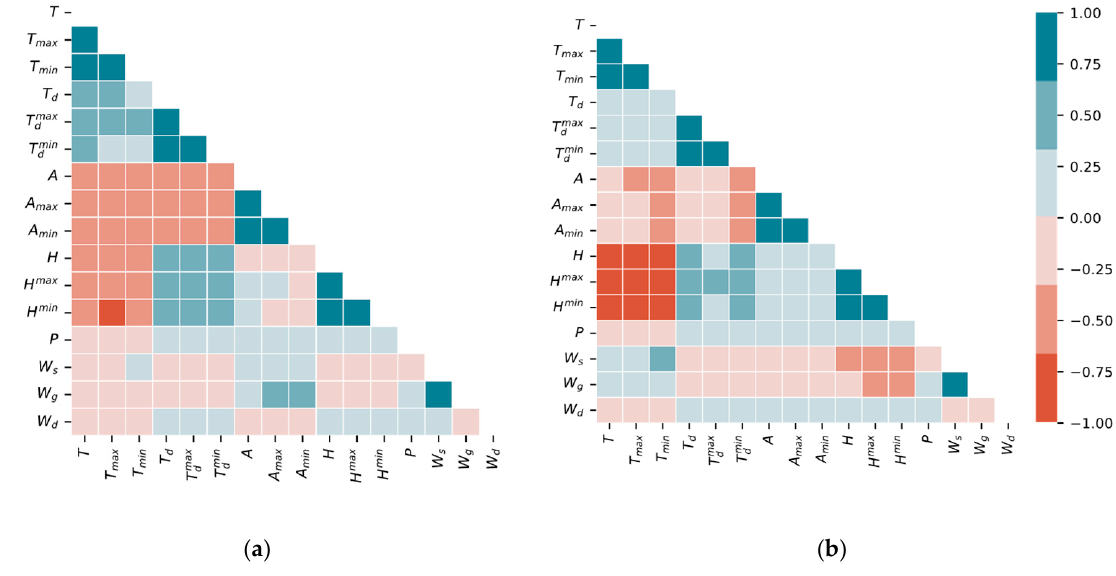
Figure 5. Correlation matrix: ( a ) winter season and ( b ) summer season. Table 3. Selected set of input variables and delay